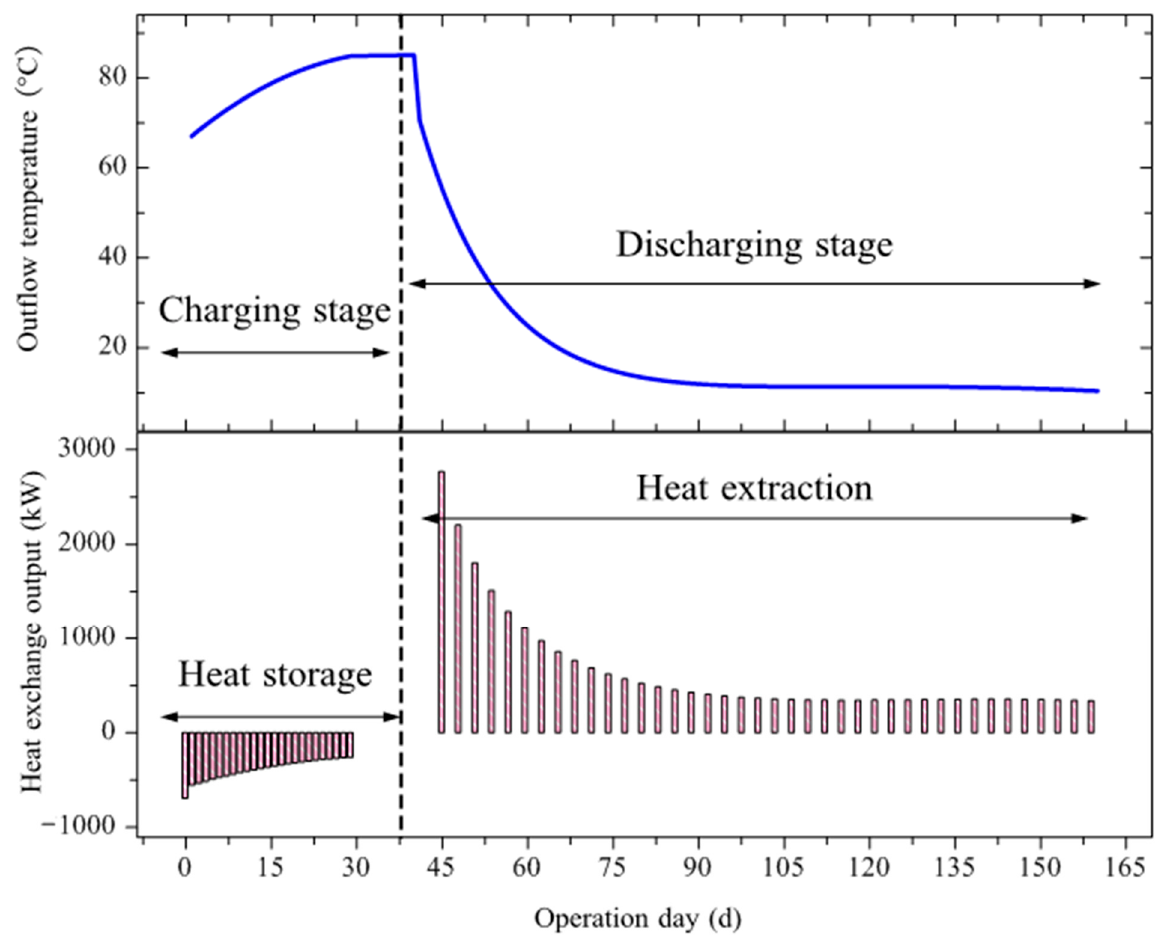
Figure 18. Dynamic evolution of outlet temperature and heat exchange output for the deep BTES system during charging and discharging